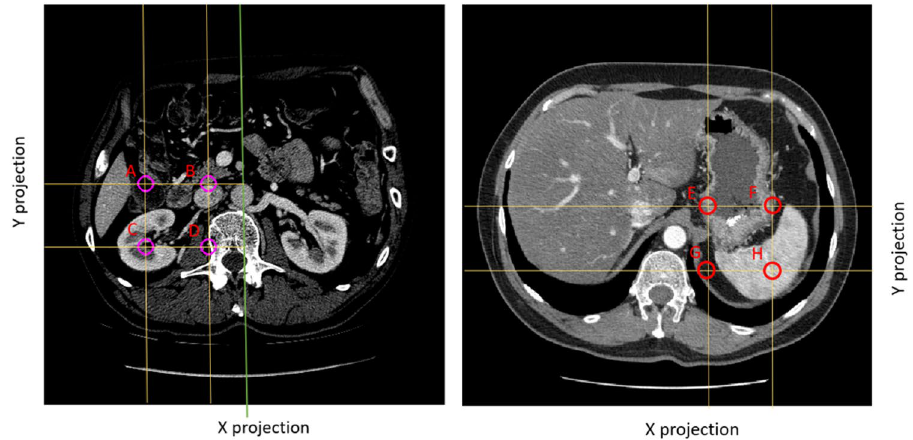
Figure 4. Example CT scan with superimposed points A, B, C, and D and intersecting axes in the X and Y axes. The green line crosses the center of the image.